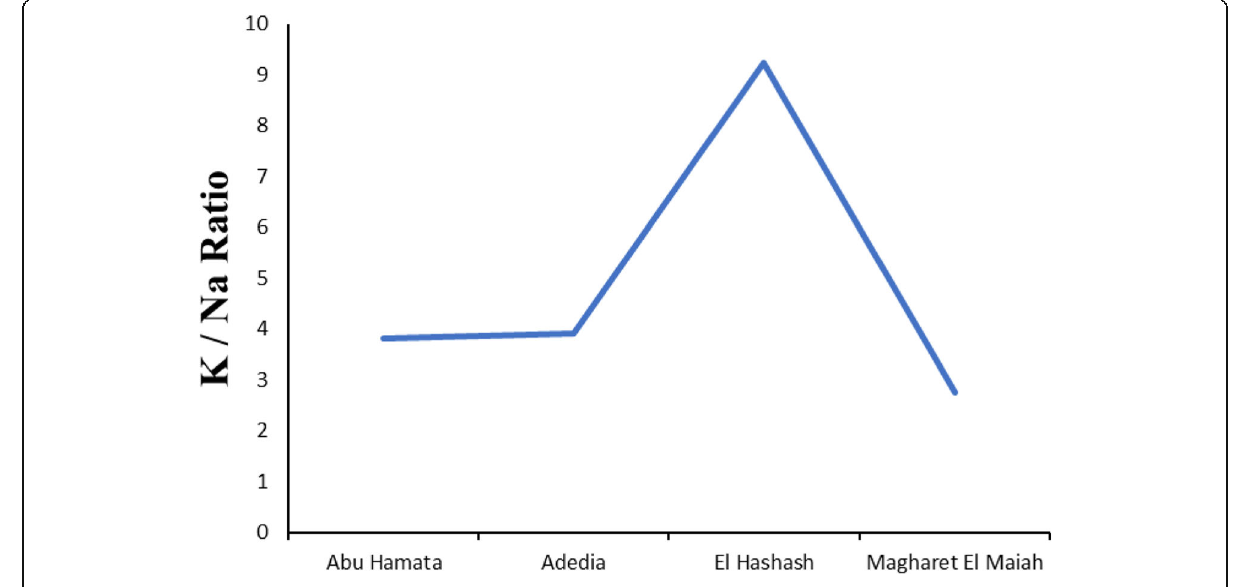
Fig. 9 K/Na ratio of the studied Paleozoic